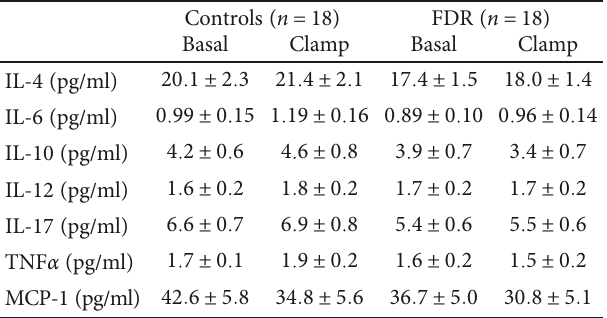
Table 3: The concentrations of cytokines in the plasma before and after the hyperinsulinemic clamp in the 2 groups of